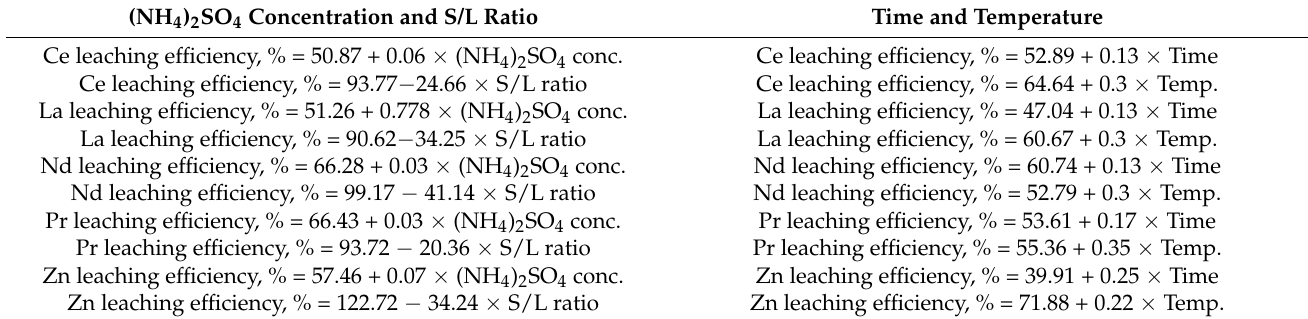
Table 3. Regression model